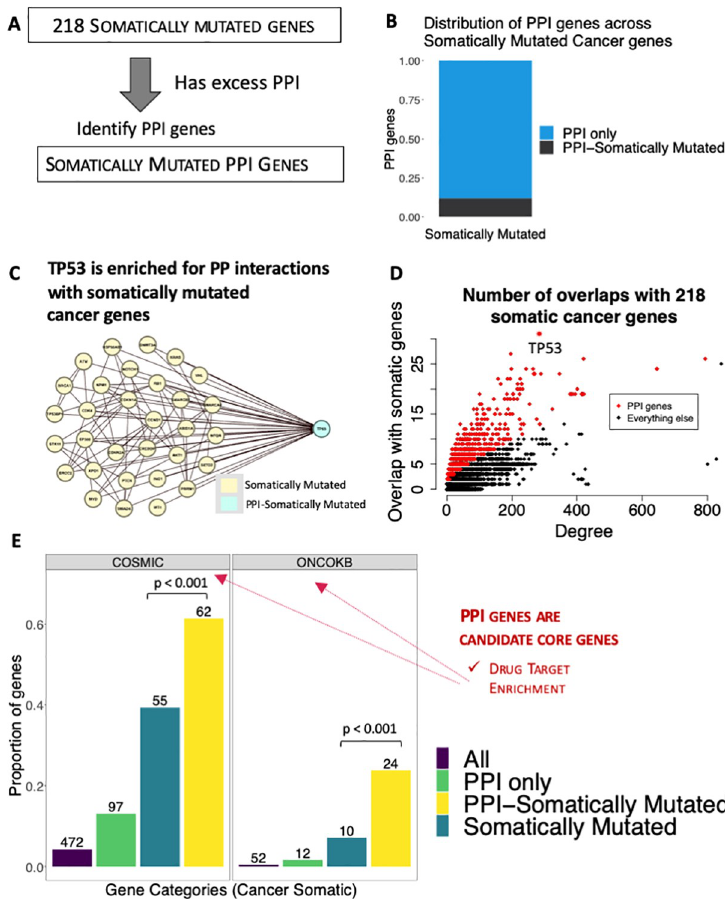
Fig 5. PPI Genes identified from Somatically mutated Cancer Genes. ( A) Schematic showing how we assessed 218 somatically mutated cancer genes for excess PPI, and then used them to predict PPI genes. ‘PPI-Somatically Mutated’: PPI genes predicted from somatically mutated cancer genes, that are also somatically mutated cancer genes themselves. ‘Somatically Mutated’: Somatically mutated genes that are not PPI genes. ‘PPI only’: PPI genes that are not in the list of 218 somatically mutated genes ‘All’: all 11,049 nodes in the network. (B) We detected 843 PPI genes from the somatically mutated cancer genes, 742 were PPI only while 101 were PPI-Somatically Mutated. (C) Amongst the PPI genes we predicted from the somatically mutated genes, ranked 2 nd was TP53 . TP53 has a degree of 284 and has PPI with 31 of the 218 somatically mutated genes. TP53 is shown in cyan, and in yellow are the 31 somatically mutated cancer genes that have PPI with TP53 . The PPI edges are represented as lines. (D) To better understand the relationship between node degree and the number of PPI edges to the 218 somatically mutated genes, we took each node in the network (n = 11,049) and counted the number of PPI edges to the 218 somatically mutated cancer genes. We plotted the number of PPI edges of each node compared to the degree of the node and show PPI genes in red, and highlight TP53 with an asterisk. (E) Overlap of somatically mutated PPI genes with COSMIC, ONCOKB or Therapeutic Targets Database genes respectively. The numbers on top of each bar correspond to the number of PPI genes that overlaps with the genes from that gene category. COSMIC: Somatically mutated genes and PPI genes were split into PPI-only, PPI-Somatically Mutated, Somatically Mutated and All (see Box 1 for definitions). Then each category was compared to the COSMIC cancer gene census somatic genes [52]. We found that PPI-Somatically mutated (p < 0.001, Fisher’s Exact Test) was enriched compared to Somatically mutated. ONCOKB: Comparison to cancer drug targets from Oncokb [53], revealed PPI-Somatically mutated was enriched compared to Somatically mutated (p < 0.001, Fisher’s Exact Test).